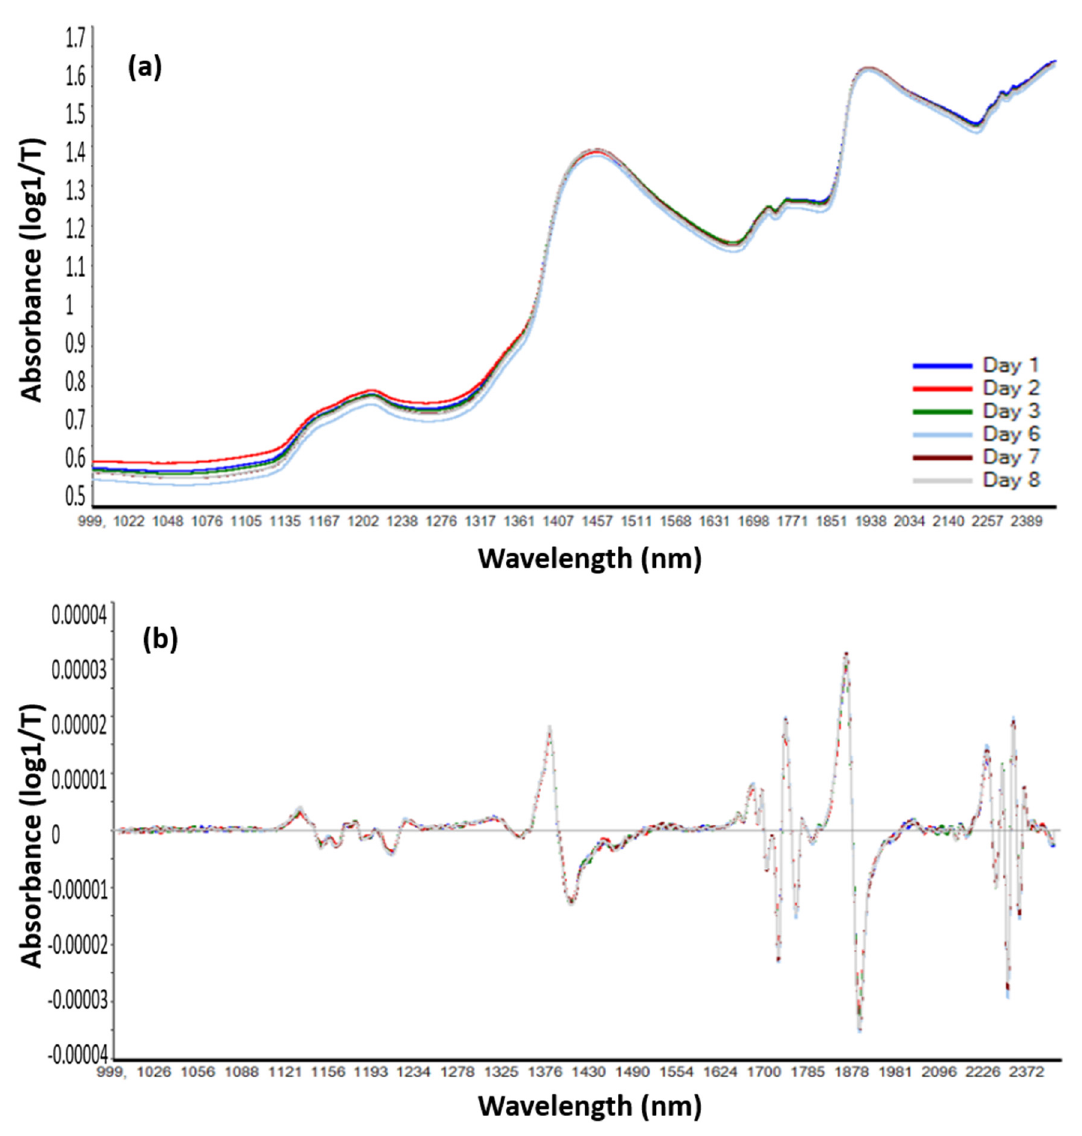
Figure 6. Variation of near infrared spectra of liquid infant milk formula; ( a ) raw, ( b ) first derivative of the NIR signal.